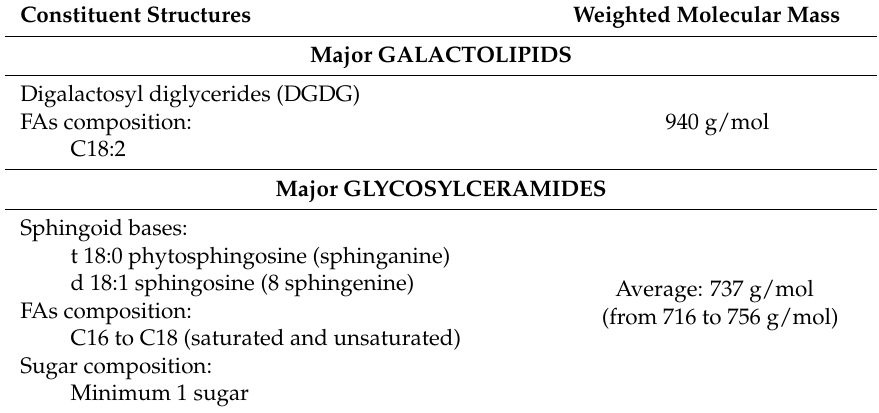
Table 1. Lipid and fatty acids (FAs) composition identified and characterized by GC/MS. Constituent Structures Weighted Molecular Mass Major